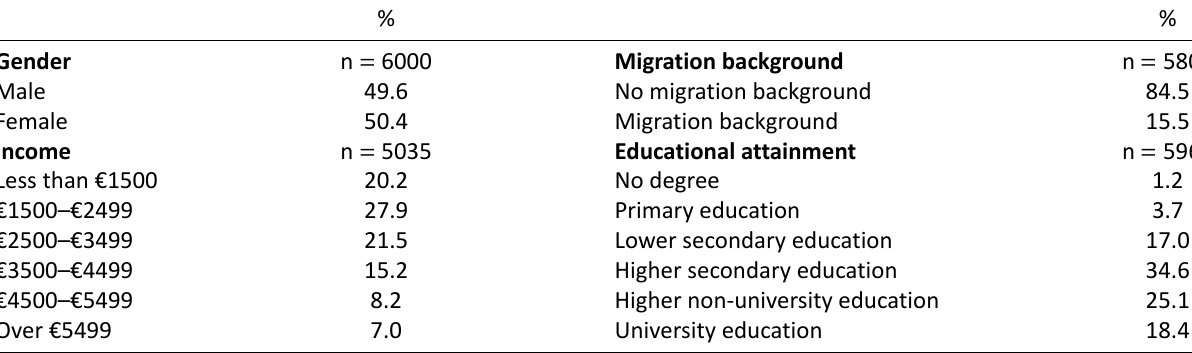
Table 1. Descriptive results of socio-demographic